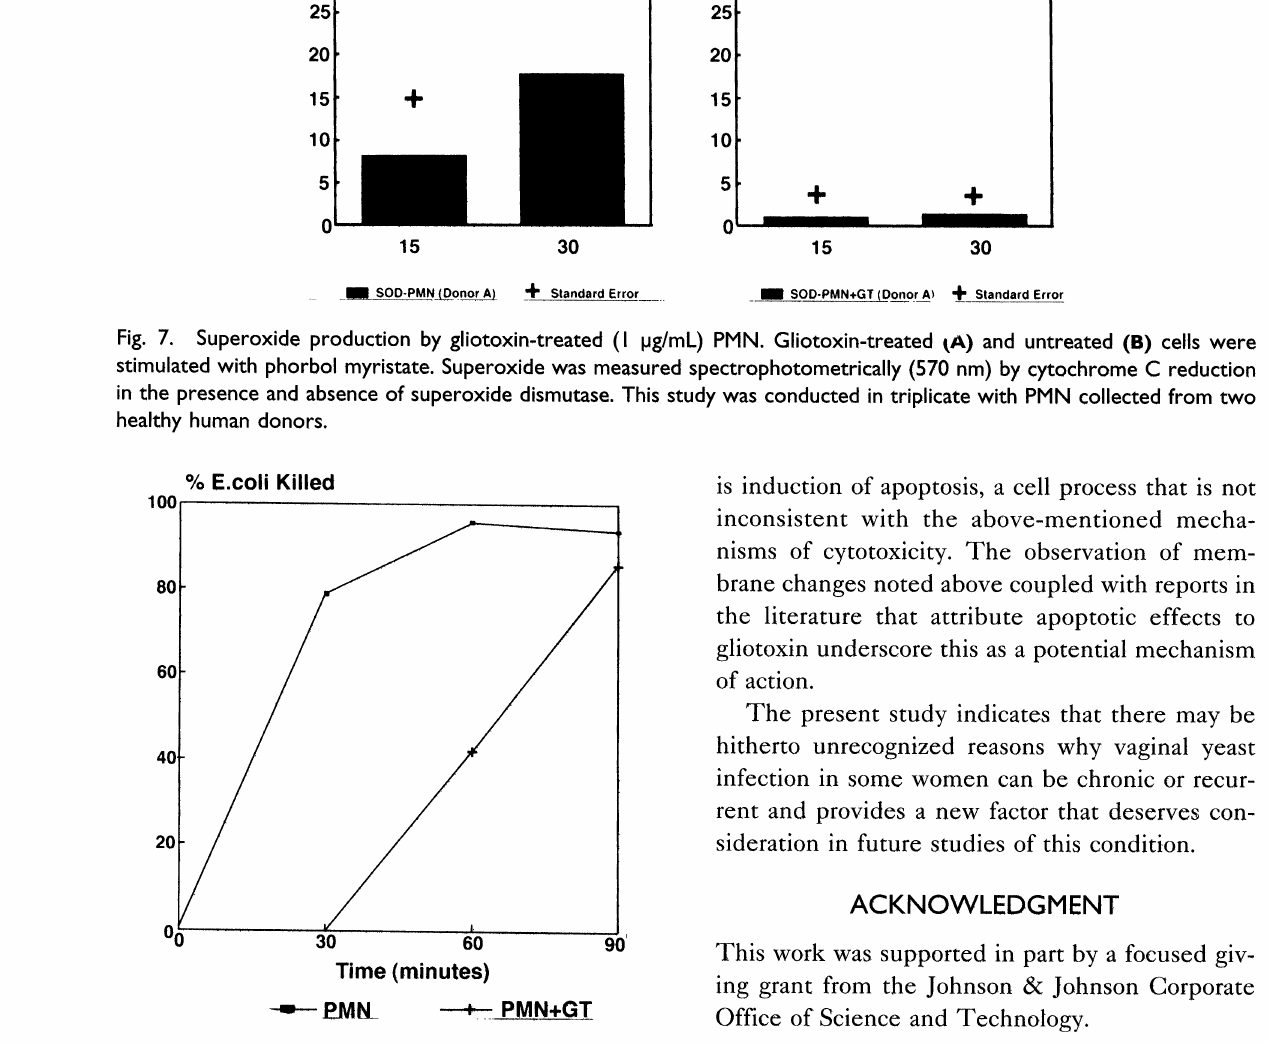
Fig. 8. Intracellular killing of E. coli by gliotoxin-treated (! IJg/mL) PMN. Intracellular killing of E. coli by gliotoxin- treated (GT) and untreated PMN was determined by dif- ferential centrifugation technique.